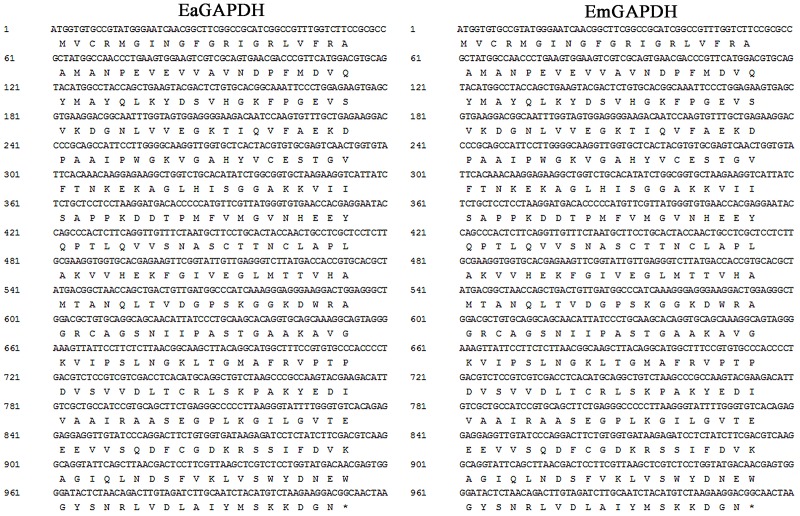
Open reading frames (ORFs) and deduced amino acid sequence of GAPDH.